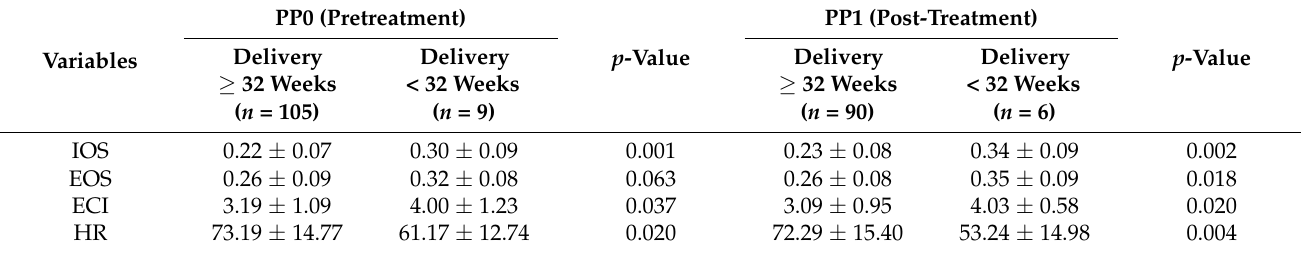
Table 2. Comparison of pre and postprogesterone elastographic parameters between the groups of delivery ≥ 32 weeks and delivery <32 weeks.